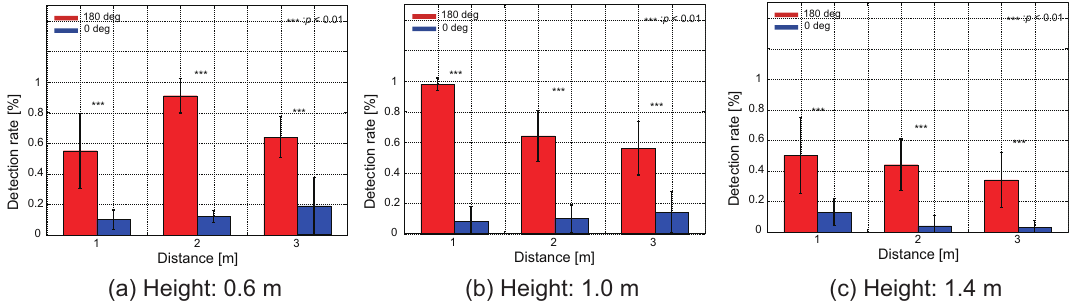
Figure 14. Detection rate of the proposed sensor arrangement. Mean and standard deviations of five iterative experiments are shown. The difference between ( a – c ) is the difference in height of the quadcopter. Red and blue bars mean the π rad condition and the 0 rad condition, respectively. We compared differences in detection rate under different heading angle conditions using the Wilcoxon rank sum test ( p < 0.01).